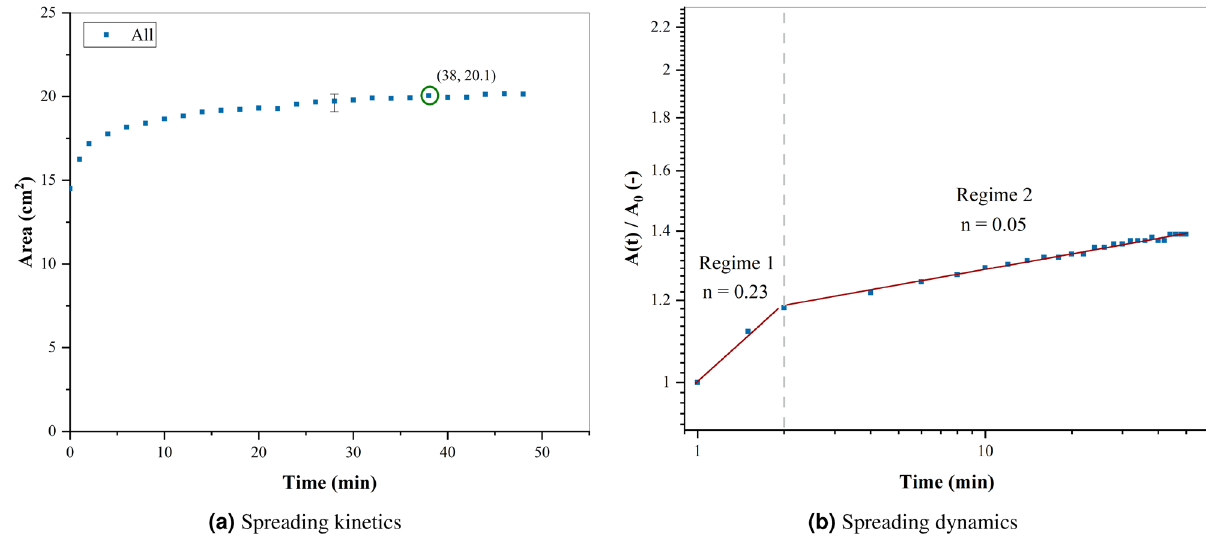
Figure 6. ( a ) Spreading kinetics of a blood pool ( m i = 4.82 g , hct = 41.5% ) on unvarnished wooden floors at 21 ◦ C with a relative humidity of 60% . ( b ) Log-log plot of the time evolution of the rescaled total pool area at 21 ◦ C with a relative humidity of 60% . The red line is a guide for the eyes, with two different values of slope. A typical error bar is presented on a single point of the curve. (OriginPro